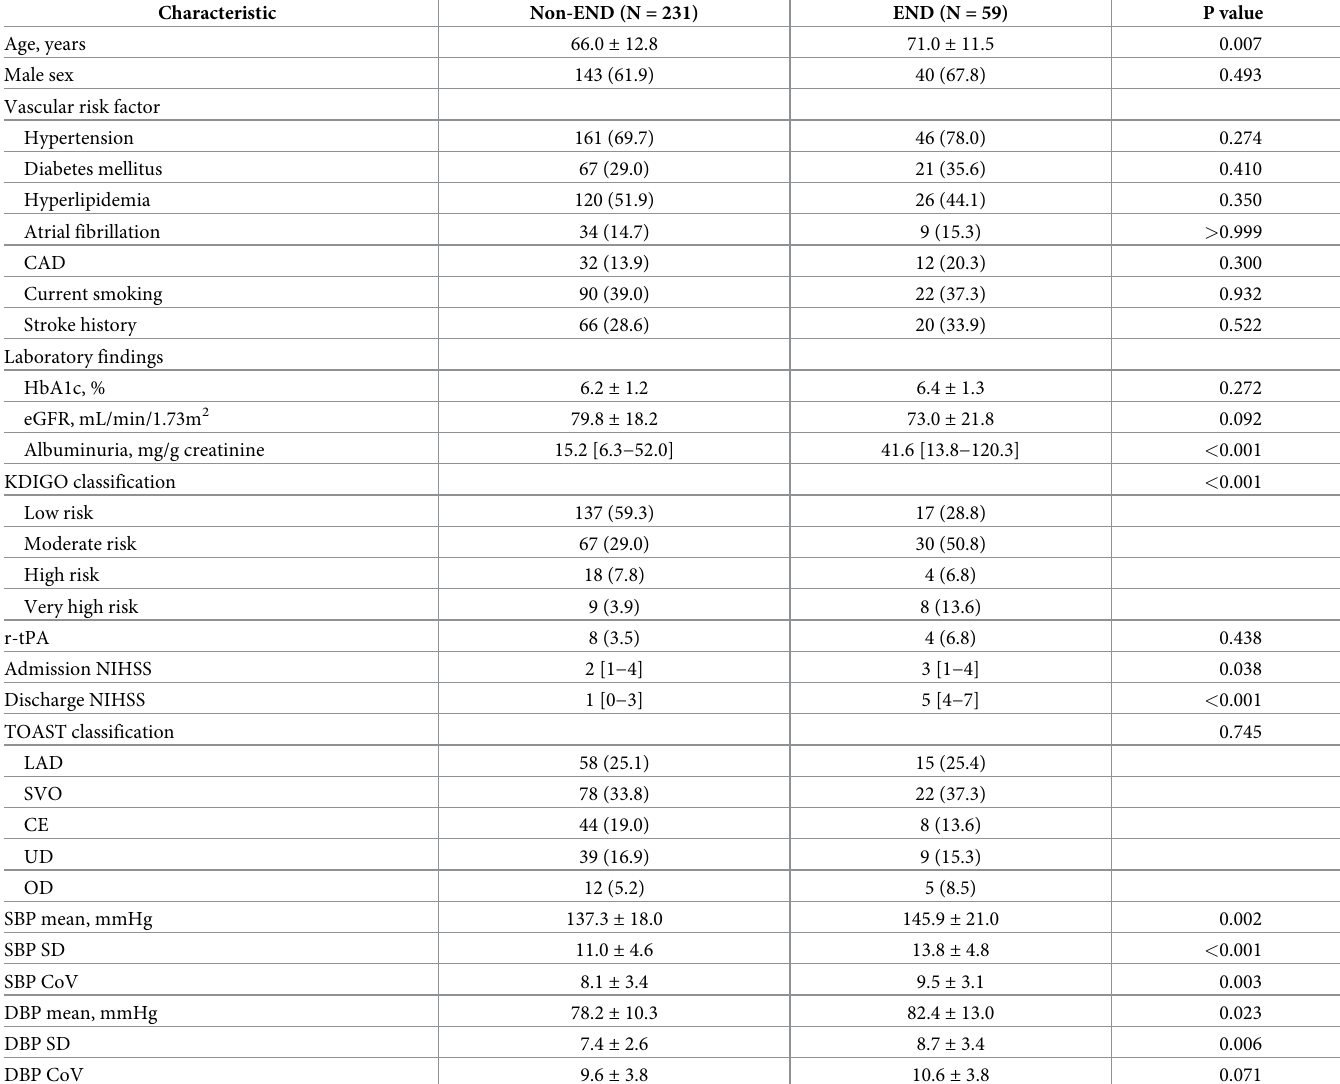
Table 2. Comparison of patient clinical characteristics and BPV in the groups with and without END. Characteristic